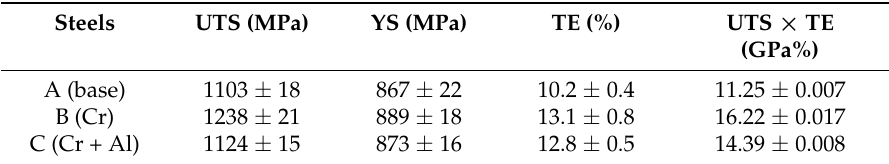
Figure 5. Engineering strain–stress curves of three tested steels with different compositions. Table 4. Mechanical Properties of steels with different compositions.